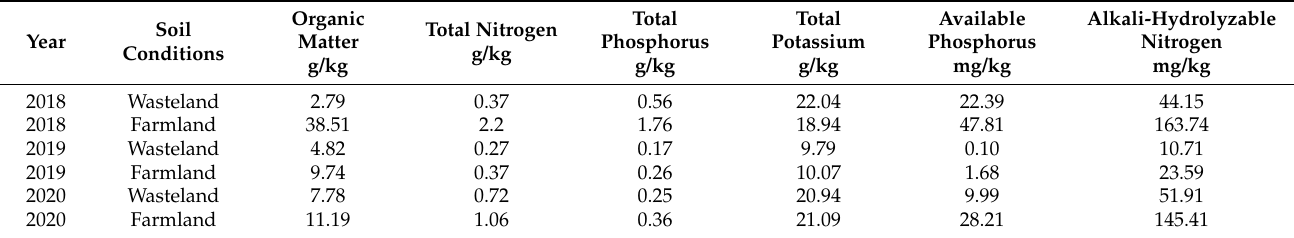
Table 6. Soil physicochemical properties per